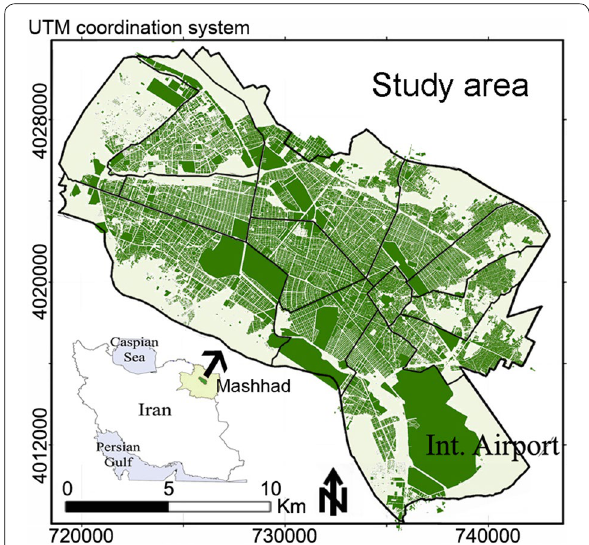
Fig. 1 Geographical location of the study area (at UTM coordination